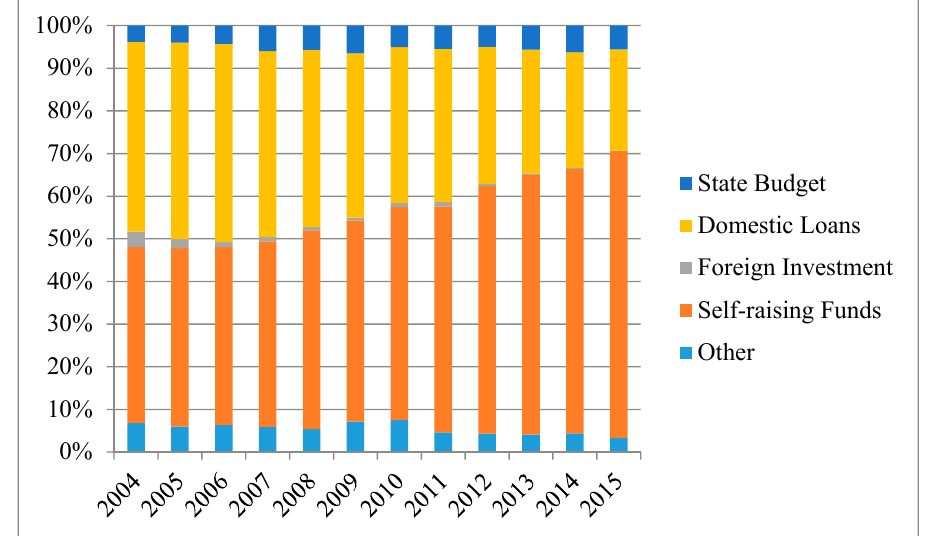
Figure 3. Fixed asset investments (FAI) in production and supply of electricity, heat, gas, and water (in urban areas), 1996–2016. Note: the data come from the National Bureau of Statistics of China.